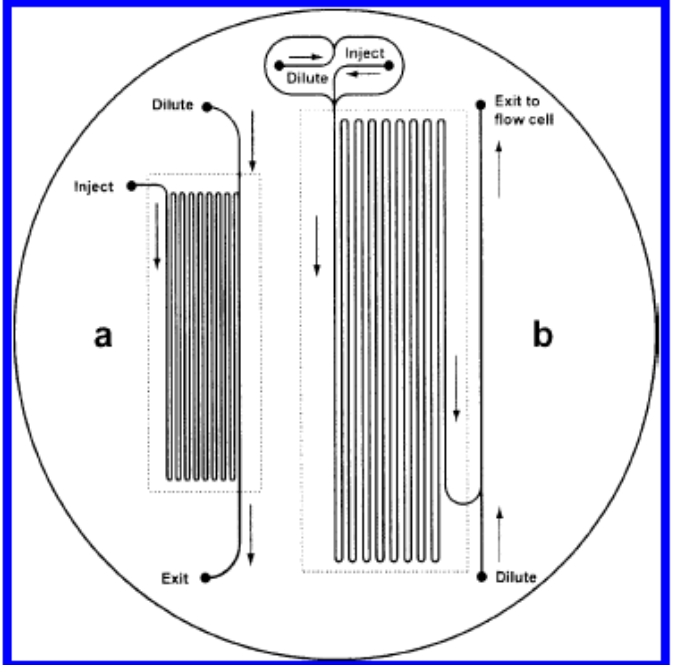
Figure 19. A chip-based microfluidic reactor for the synthesis of CdSe nanocrystals. Nanocrystals are sized through their continuous photoluminescence data